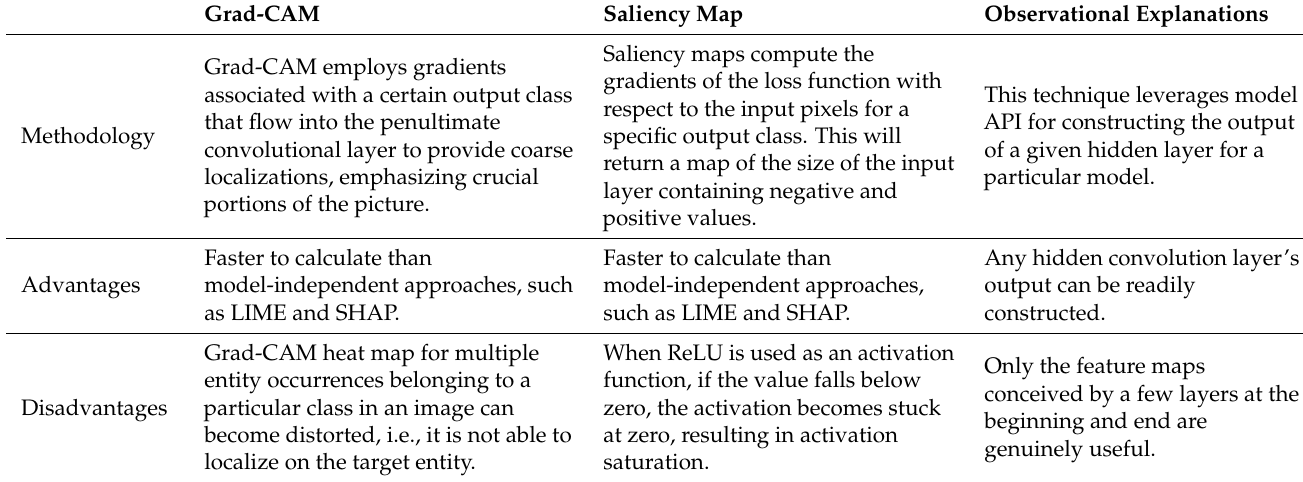
Table 7. Comparison of XAI